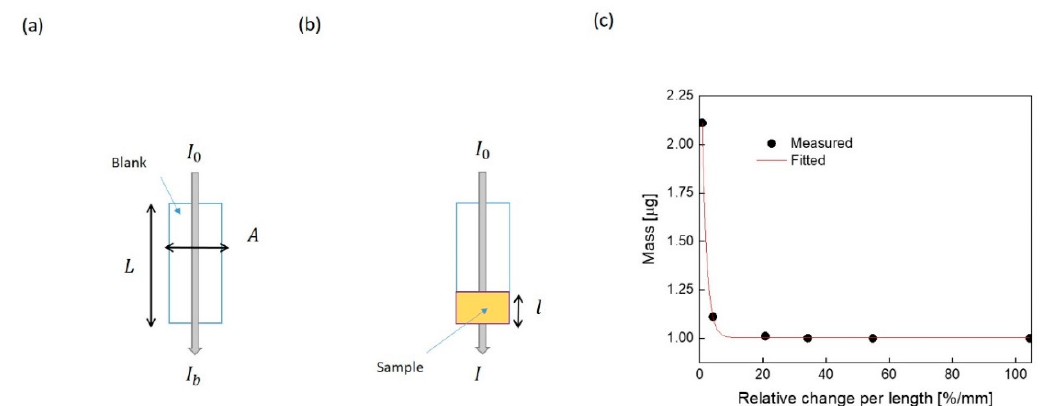
Figure 4. Illustration of light intensity and its path length: ( a ) the blank representation, and ( b ) light path length of the sample. L and A are the length and cross-sectional area of container, l is the light path length. I 0 , I b , and I are the incident, blank, and instantaneous sample intensities, respectively. ( c ) Loaded mass vs. relative change in light intensity per light-path length. The measured points were fitted with exponential function expressed by Equation (1) with the following parameters: m i = 1.003 μ ± 2.68n, m f = 2.163 μ ± 34.7n, and α -factor is 1.28435 ± 0.030. The other fitting model accuracy parameters are reduced Chi-Sqr, R-Square (COD), Adj. R-Square are 28.8 atto, 1 and 1, respectively, which indicates the best possible fit.